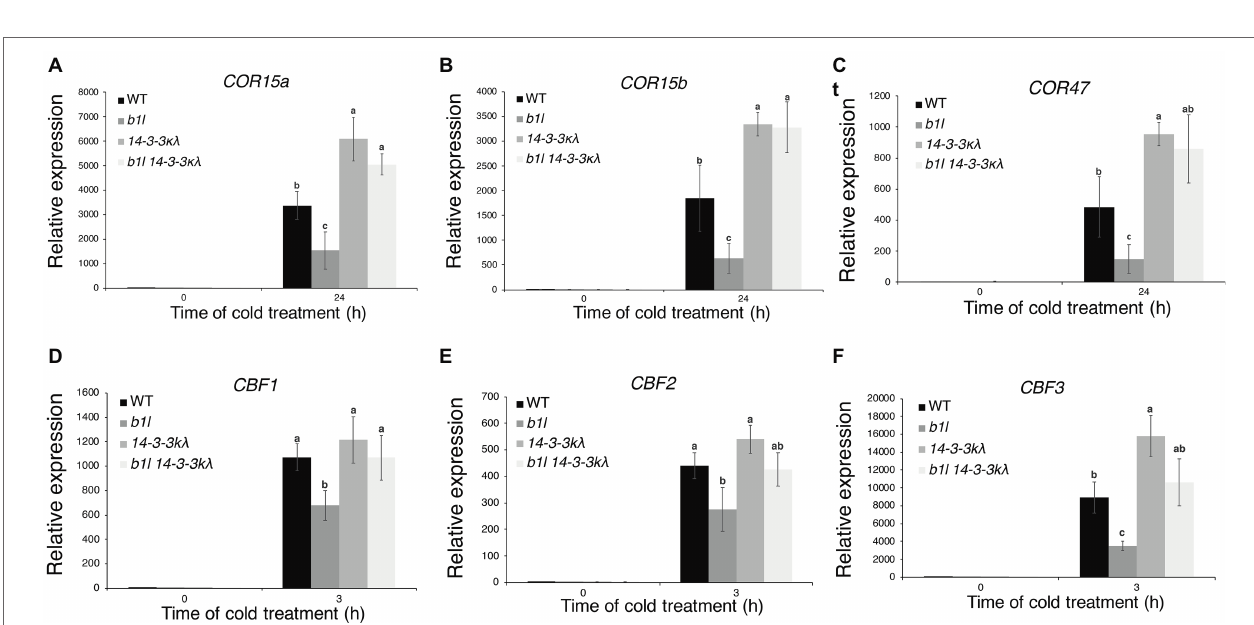
FIGURE 5 | B1L regulates freezing tolerance via a 14-3-3 λ -dependent way. Freezing tolerance (A,C) and survival rates (B,D) of 14-3-3k λ mutants and b1l 14-3- 3k λ mutants under NA or CA conditions. The assays were performed as in Figure 1 . The data are shown as means of three independent biological replicates ± SD. Asterisks indicate significant differences (* p < 0.05, and ** p < 0.01) from wild